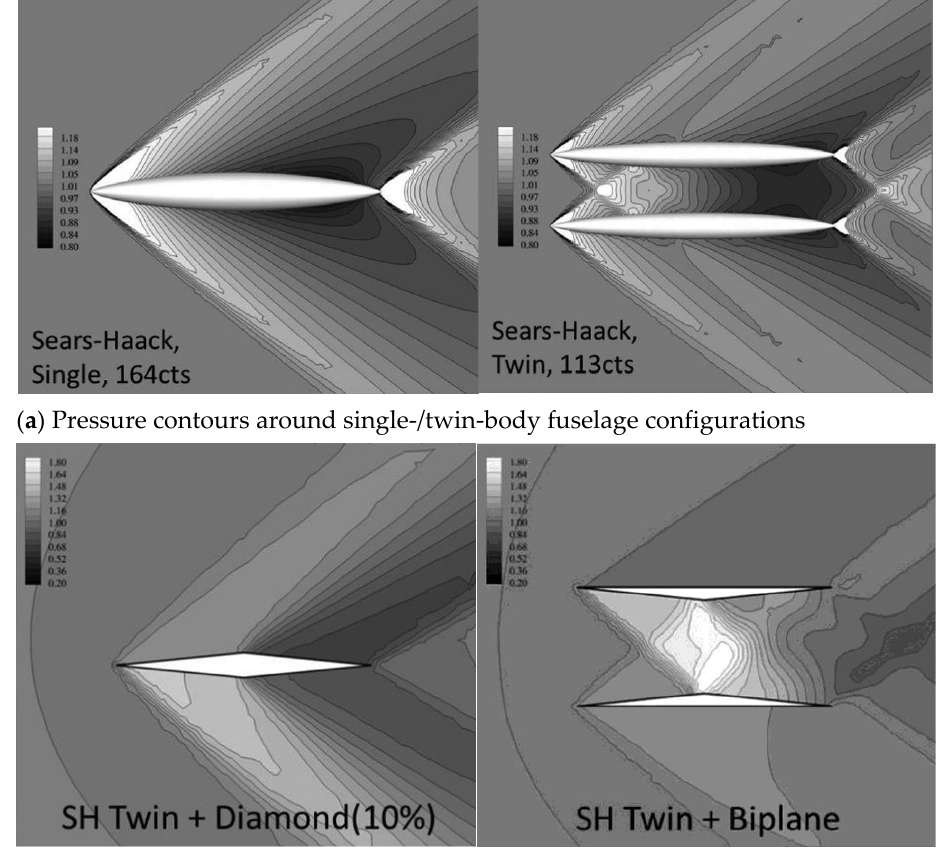
Figure 10. Pressure contours [22].